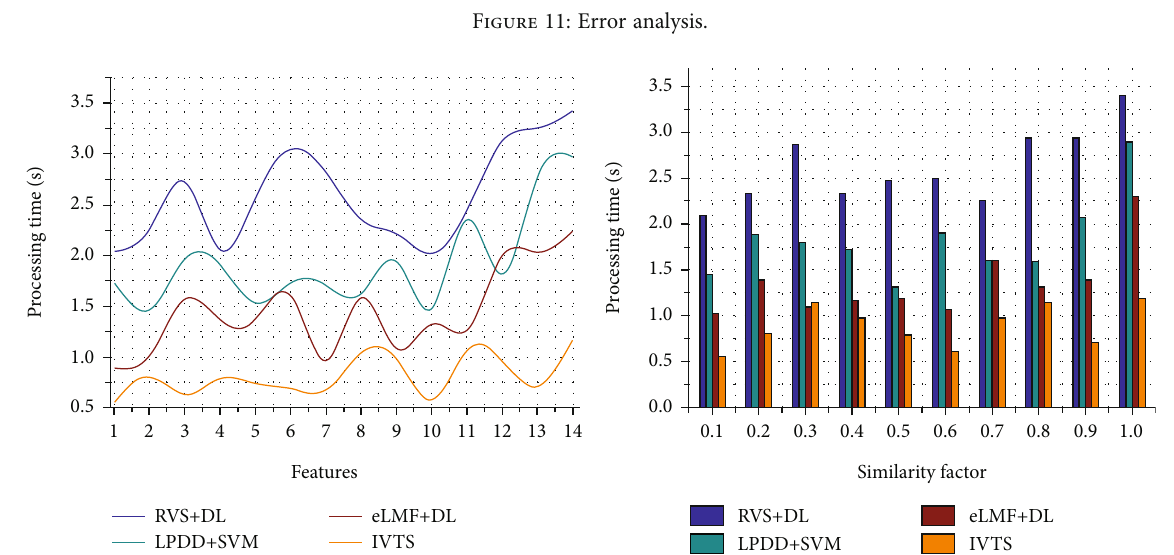
Figure 11: Error analysis.